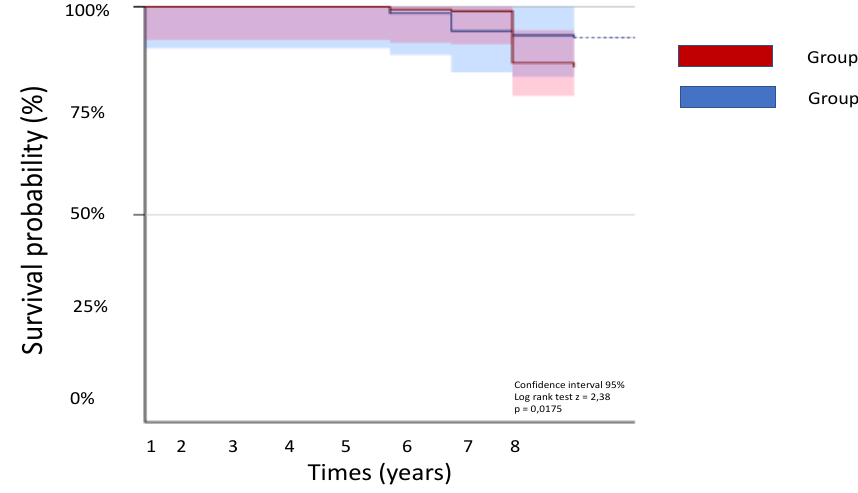
Figure 2. Kaplan-Meier curves of the two study groups.